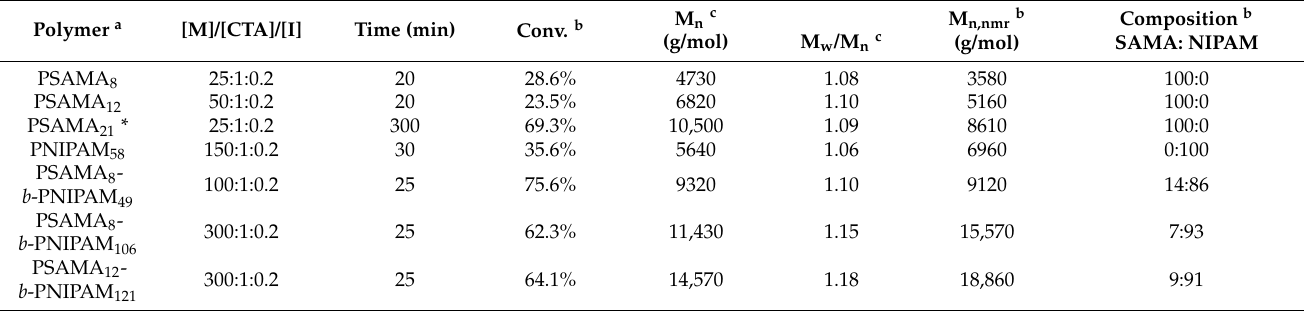
Table 1. Microwave-assisted RAFT polymerization of PSAMA, PNIPAM and PSAMA- b -PNIPAM at 60 ◦